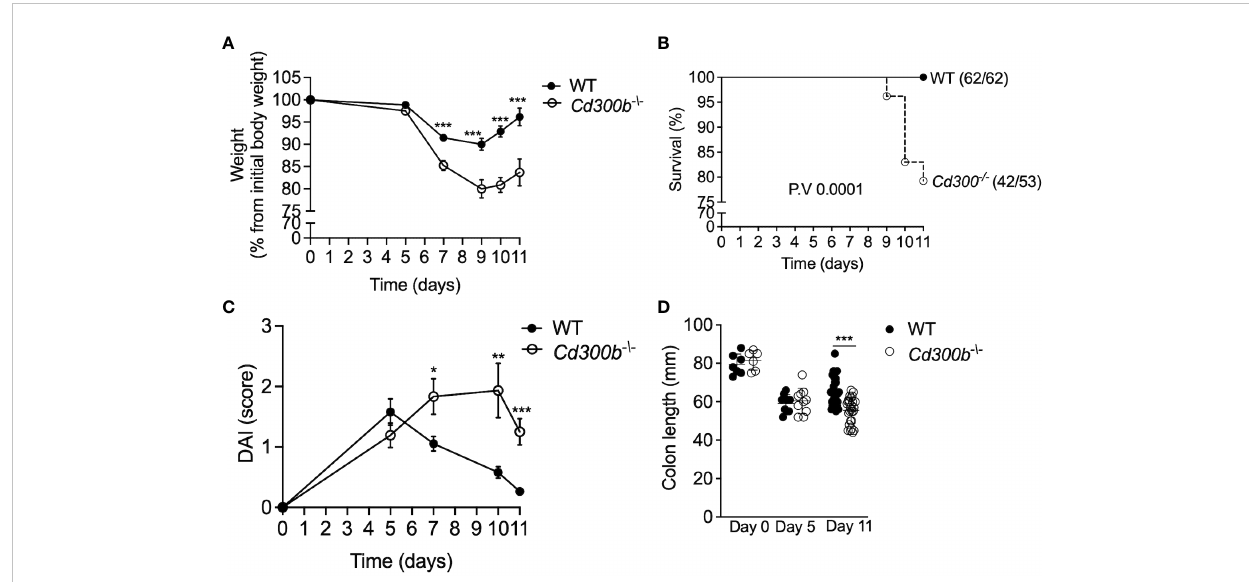
FIGURE 3 Cd300b -/- mice display defects in resolving DSS-induced in fl ammation. WT and Cd300b -/- mice were subjected to 2% DSS in their drinking water for fi ve days followed by six days of DSS-cessation. Mice were analyzed for weight loss (A) , survival (B) , clinical disease activity index (DAI) (C) , and colon length (D) . Graphs (A, C) are representative of n=4 experiments conducted with 13-16 mice. In (B) numbers in parentheses represent the ratio between the total amount of dead mice to total mice used in all experiments. In (D) , Each circle represents one mouse. *p<0.05, **p<0.01,